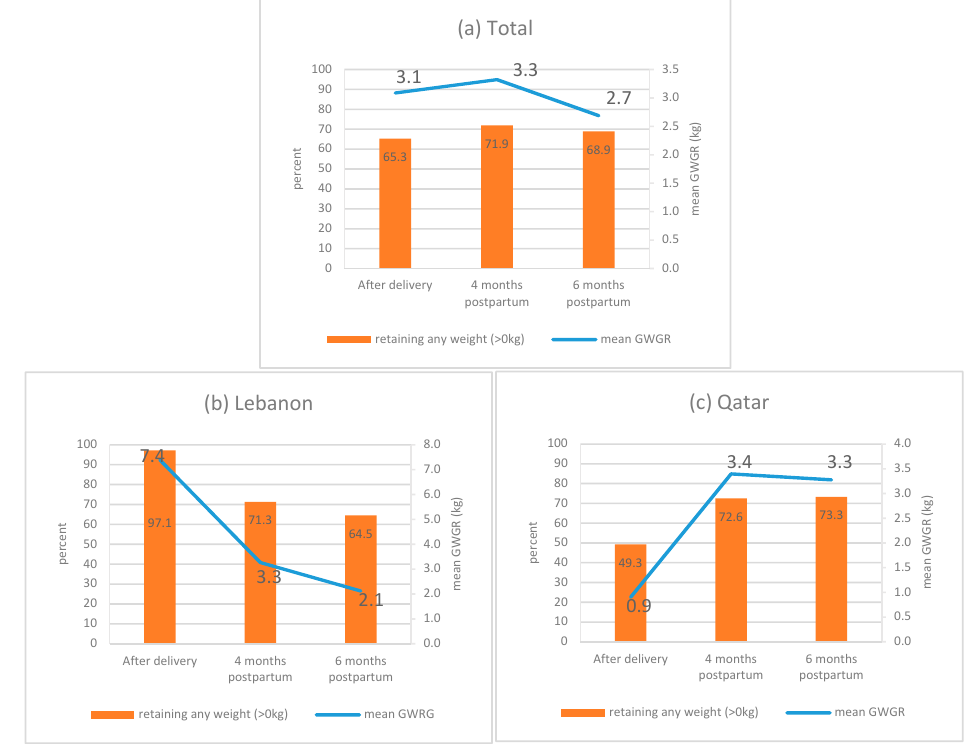
Figure 2. Mean PWR and percentage of women retaining any weight (>0 kg) at PWR 0 , PWR 4 , and PWR 6 among: ( a ) the total sample; ( b ) among Lebanese residents; and ( c ) among Qatari residents.